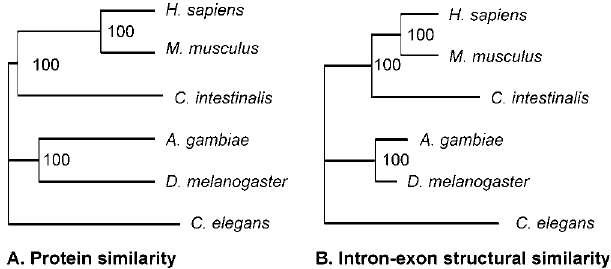
Figure 3. Neighbor-Joining Trees Summarizing Proteome-Wide Trends in Protein Similarity and Genome-Wide Trends in Intron–Exon Structural